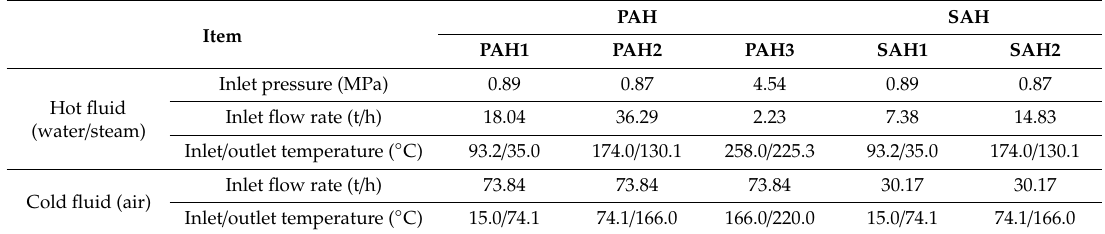
Table 8. Parameters of the air preheating system in the WtE section of the integrated